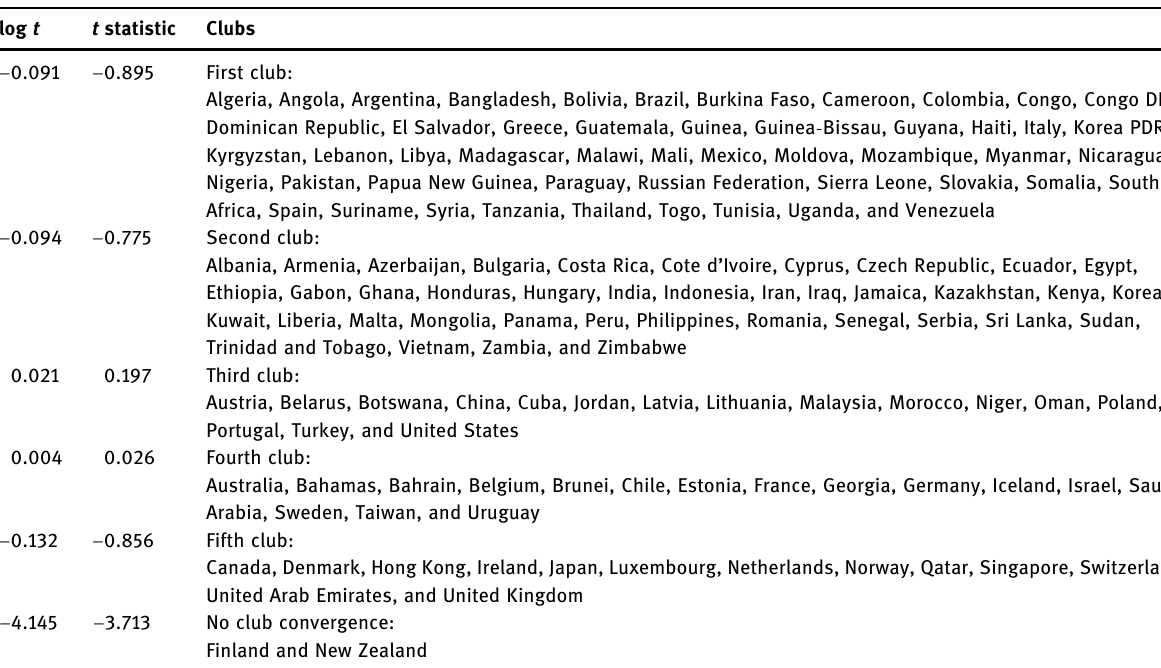
Table 5: Final cluster convergence analysis ( 1984 – 2017 )